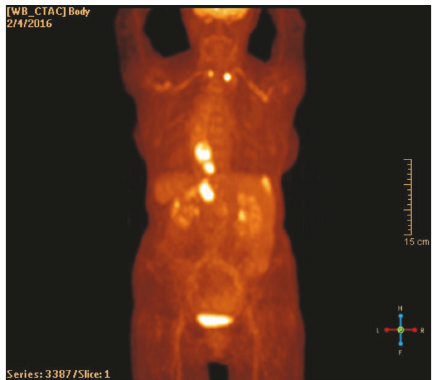
Figure 4: PET scan demonstrating a hypermetabolic mass in the distalesophagus.Also,ahypermetabolicliverlesionandanenlarged gastroesophageal lymph node are seen. This PET scan incidentally revealed bilateral hypermetabolic thyroid